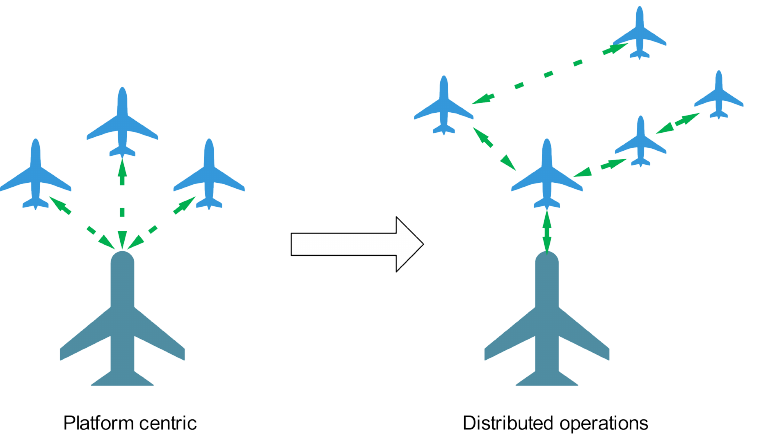
Figure 9. Collaborative Operations in Denied Environment (CODE)